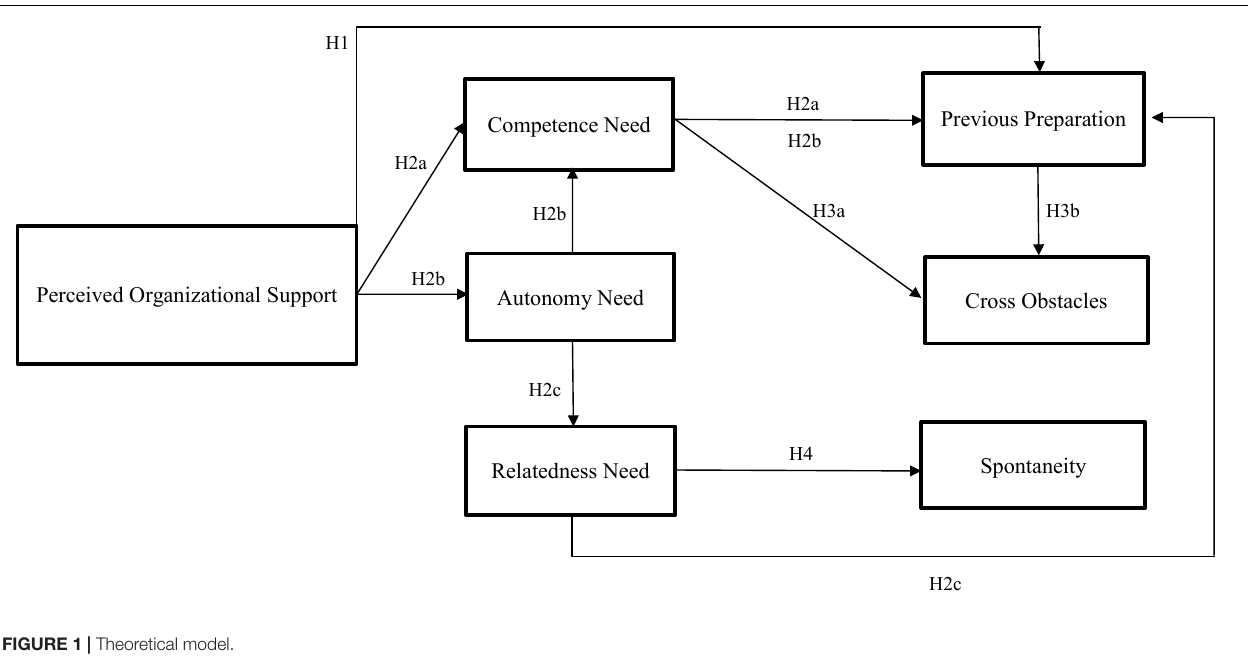
FIGURE 1 | Theoretical